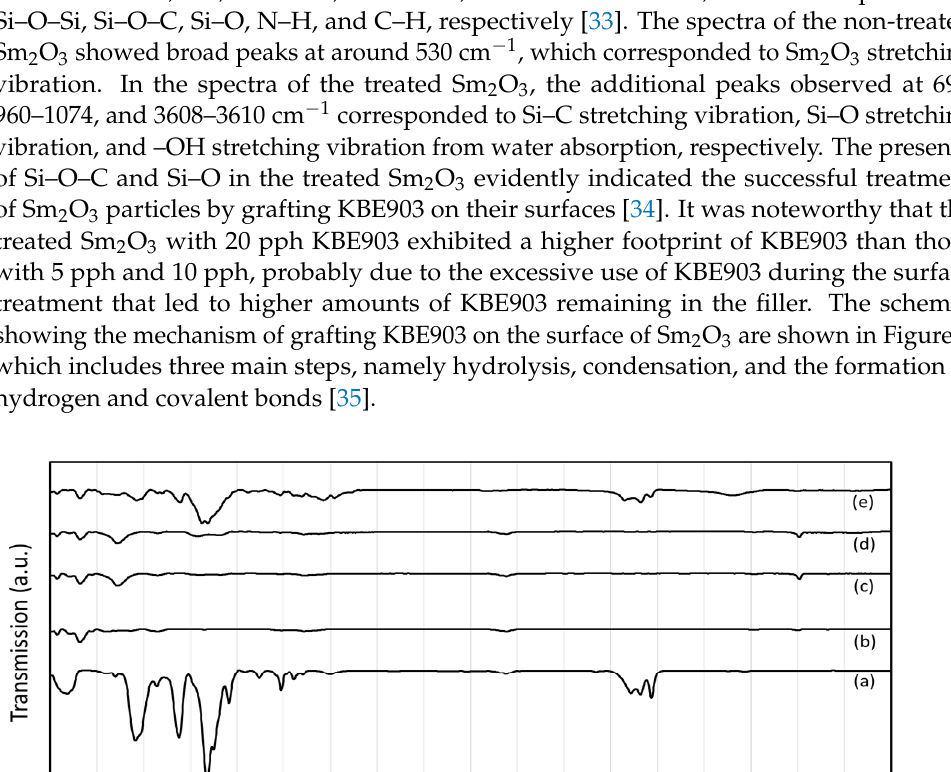
Figure 3. Schemes showing mechanisms of grafting KBE903 on surface of Sm 2 O 3 , including ( a ) hy- drolysis, ( b ) condensation, and ( c ) hydrogen bond and covalent bond formation. The average particle sizes of Sm 2 O 3 for each treatment were determined by using the ImageJ software. The results revealed that the Sm 2 O 3 particles with 20 pph KBE903 had the largest average particle size as well as the largest deviation in particle sizes of 21.5 ± 5.3 µm compared to the non-treated Sm 2 O 3 (15.3 ± 5.3 µm) and treated Sm 2 O 3 at 5 pph and 10 pph KBE903 (14.3 ± 2.9 µm and 11.7 ± 2.4 µm, respectively). This behavior was observed because, although the application of KBE903 at low contents (5 and 10 pph in this work) could limit/reduce particle agglomeration after the treatment, excessive use of KBE903